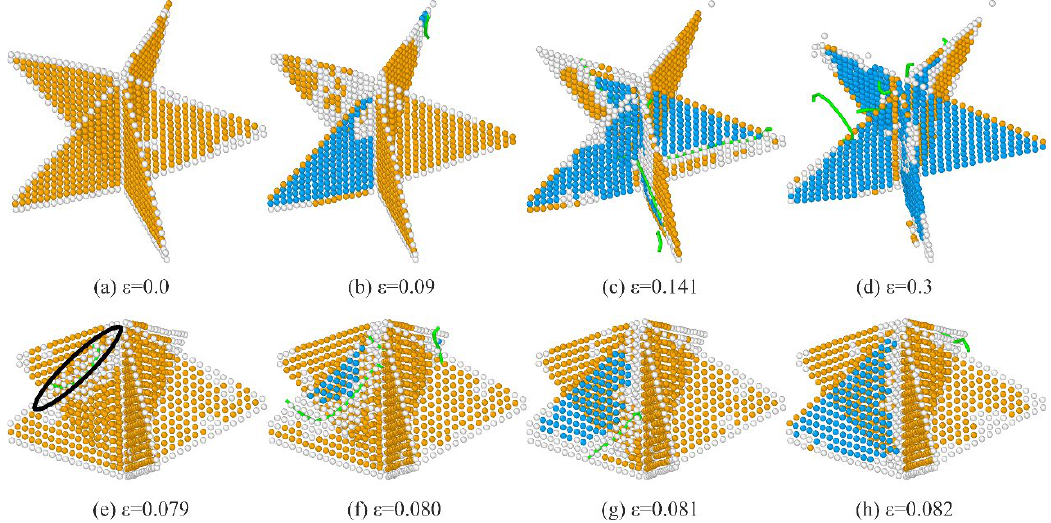
Figure 10. Snapshots of the slippage contributed by the propagation of Shockley partial dislocations in the TB of penta twins: ( a – d ) Evolutions of slips in each TB; ( e – h ) Propagation of Shockley dislocations on the first TB. FCC structures are colored blue, and HCP structures are colored orange. ( a ) ε= 0.0, ( b ) ε= 0.09, ( c ) ε= 0.141, ( d ) ε= 0.3, ( e ) ε= 0.079, ( f ) ε= 0.080, ( g ) ε= 0.081, ( h ) ε= 0.082.